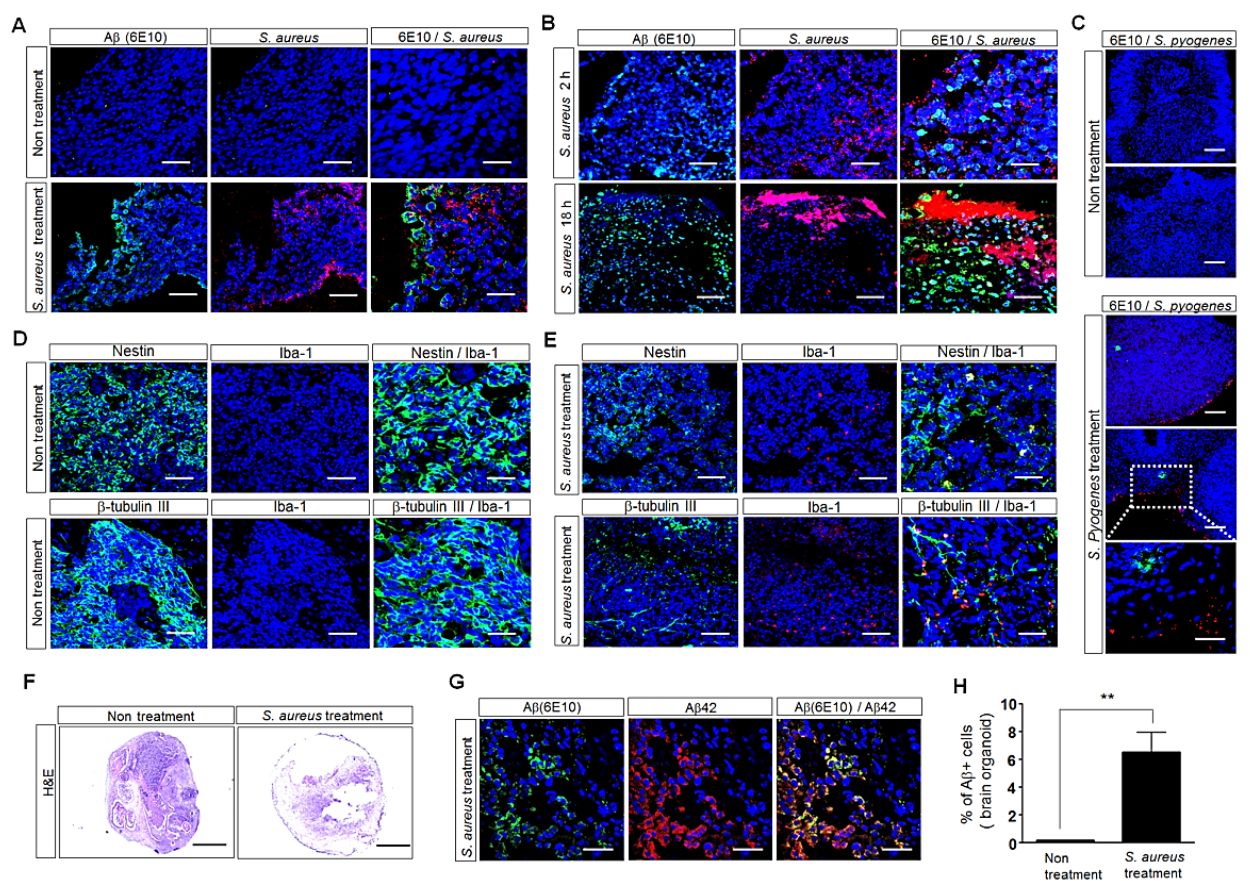
Figure 5. Histological analyses of hiPSC-derived human brain organoids subjected to immuno- histostaining. ( A ) Confocal-microscopy images of human brain organoids cultured for 2 h in the absence or presence of S. aureus at an MOI of 10 after the double staining of the OCT-embedded sections with the A β -specific 6E10antibody (green) and the antibody against S. aureus (red). Nuclei were labeled with DAPI (blue). Scale bars: 50 µ m, 20 µ m. All images are representative of two independent experiments. ( B ) Confocal-microscopy images of human brain organoids cultured for 2 h or 18 h in the presence of S. aureus at an MOI of 10 after the double staining of the OCT-embedded organoid sections with the A β -specific 6E10antibody (green) and the antibody against S. aureus (red). Nuclei were labeled with DAPI (blue). Scale bars: 50 µ m, 20 µ m. ( C ) Confocal-microscopy images of human brain organoids cultured for 5 h in the presence of S. pyogenes after the double staining of the OCT-embedded organoid sections with the A β -specific 6E10antibody (green) and the antibody against S. pyogenes (red). Nuclei were labeled with DAPI (blue). Scale bars: 100 µ m, 10 µ m. ( D , E ) Confocal-microscopy images of human brain organoids cultured in the absence or presence of S. aureus at an MOI of 10 after the double staining of the OCT-embedded sections with antibodies against Nestin (green) and Iba-1 (red) or against β -tubulin III (green) and Iba-1 (red). Nuclei were labeled with DAPI (blue). Scale bars: 50 µ m, 20 µ m. All images are representative of two or three independent experiments. ( F ) H&E staining of the OCT-embedded sections at 2 h after incubation of the human brain organoids cultured in the absence or presence of S. aureus at an MOI of 10. Scale bar: 500 µ m. ( G ) Confocal-microscopy images after the double staining of OCT-embedded organoid sections with antibodies against 6E10antibody (green) or A β 42 antibody (red) to detect A β deposition. Scale bar: 20 µ m. ( H ) A β -positive organoids were counted. Each bar represents the mean percent of the A β -positive cells in the organoids ± SD. Values are the means (SD). A Student’s t-test was used to determine the statistical differences between two different samples. ** p < 0.01.